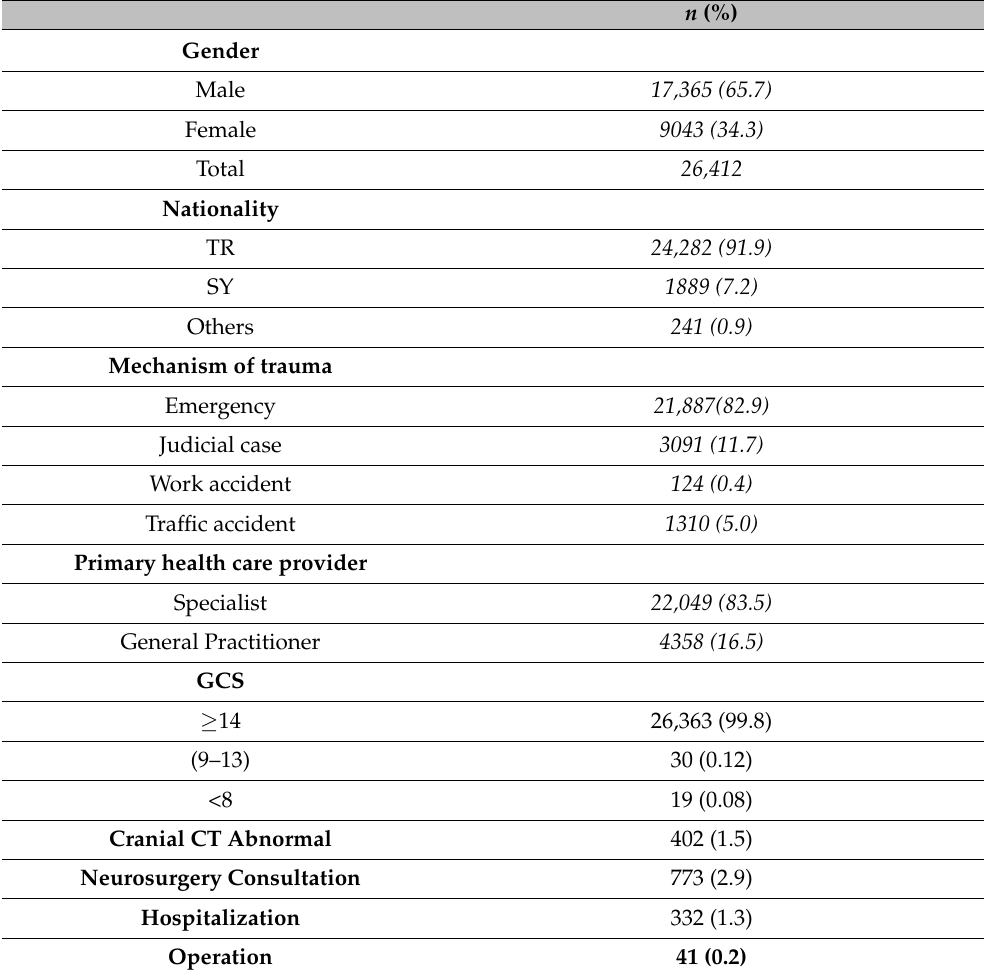
Table 1. The demographic and the clinical features of the